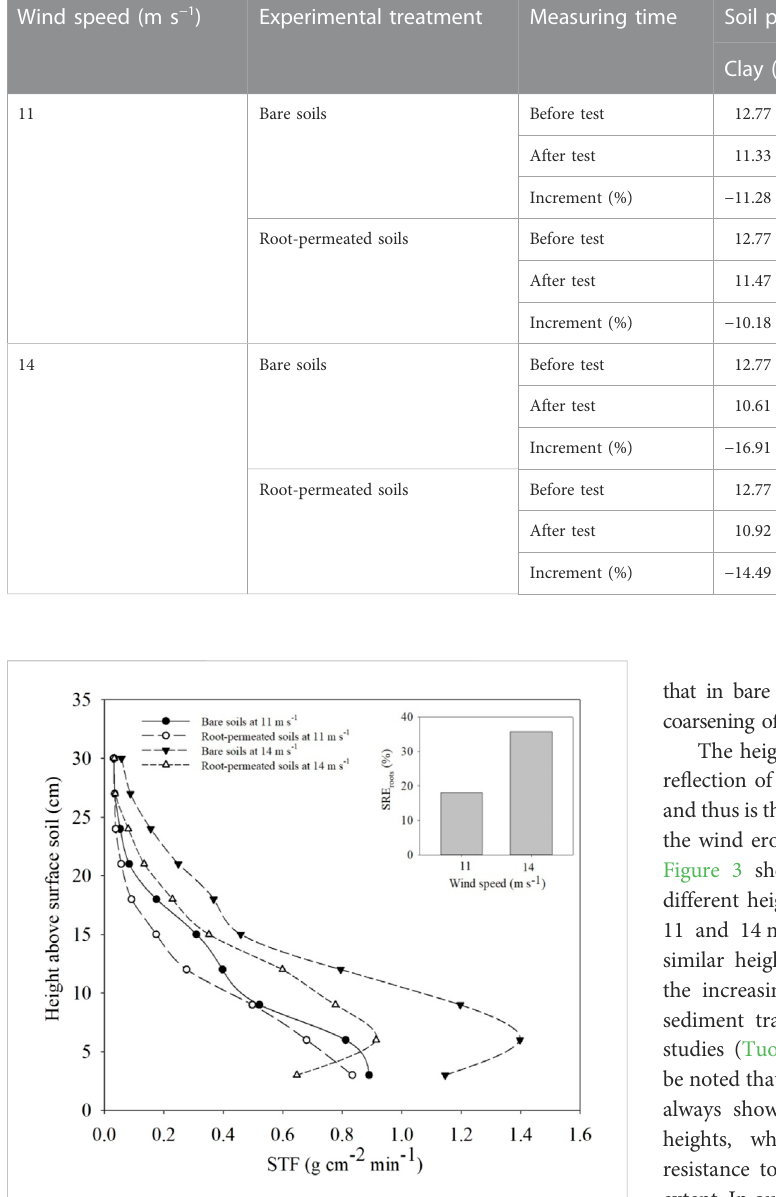
Sediment transport fl ux (STF) at different ground heights and the sediment reduction effect by roots (SRE roots , %) at wind speeds of 11 and 14 m s − 1